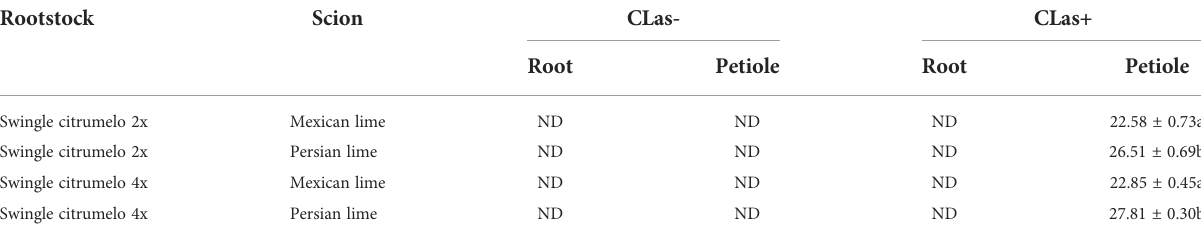
TABLE 2 Quantitative real-time PCR in roots of 2x and 4x Swingle citrumelo and petioles from Mexican and Persian limes of the control (CLas-) and infected samples (CLas+).